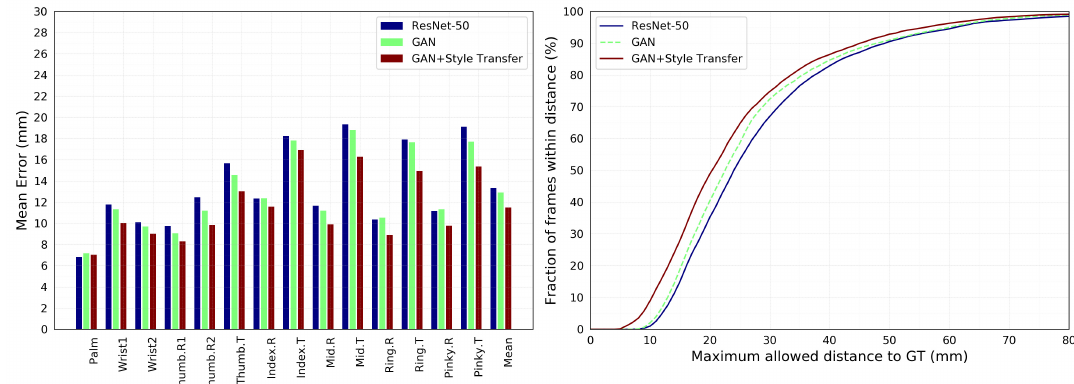
Figure 6. On NYU dataset, the contribution of the different parts to the accuracy are compared. Left : Each joint error. Right : The fraction of frames over different maximum Euclidean distance error thresholds. The large area below the curve indicates better results. The entire model performs best in the graph. (Best viewed on screen).